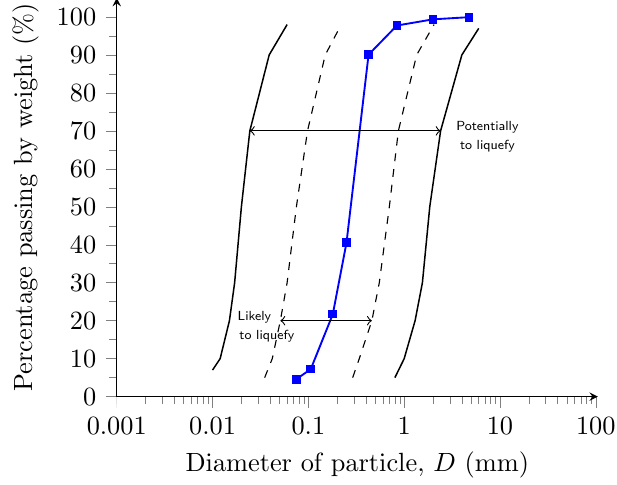
Figure 3. Grain size distribution curve.